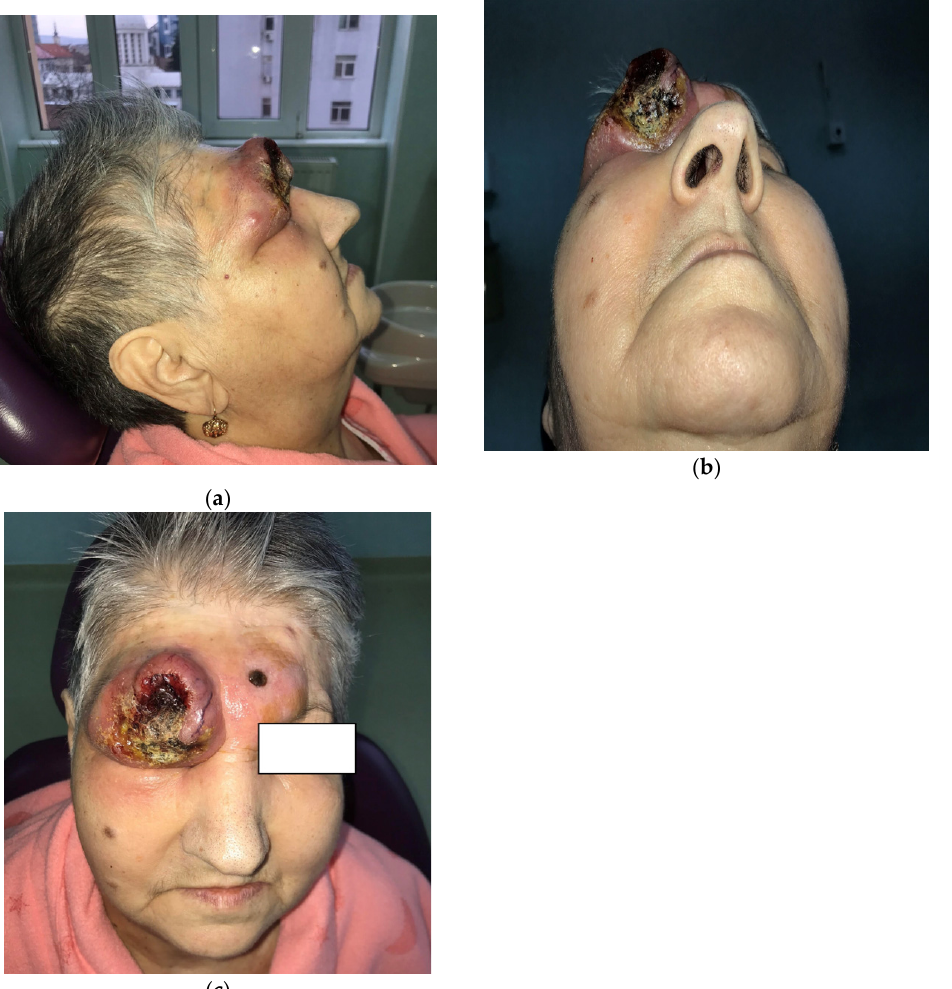
Figure 1. ( a – c ) The initial visit, which revealed a 6 cm ill-defined tumor-like lesion, red-violaceous with visible telangiectasia that presented with an ulcerated central area and crusting.